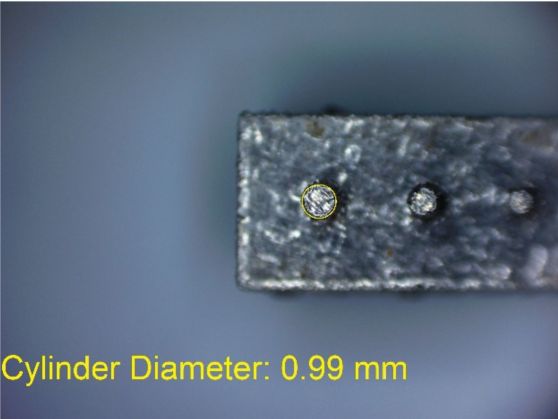
Figure 11. Measurement result for cylindrical holes and solids made in the DMLS technology: cylinder with a nominal diameter D m = Ø1 mm (D m1 = 0.99 mm).